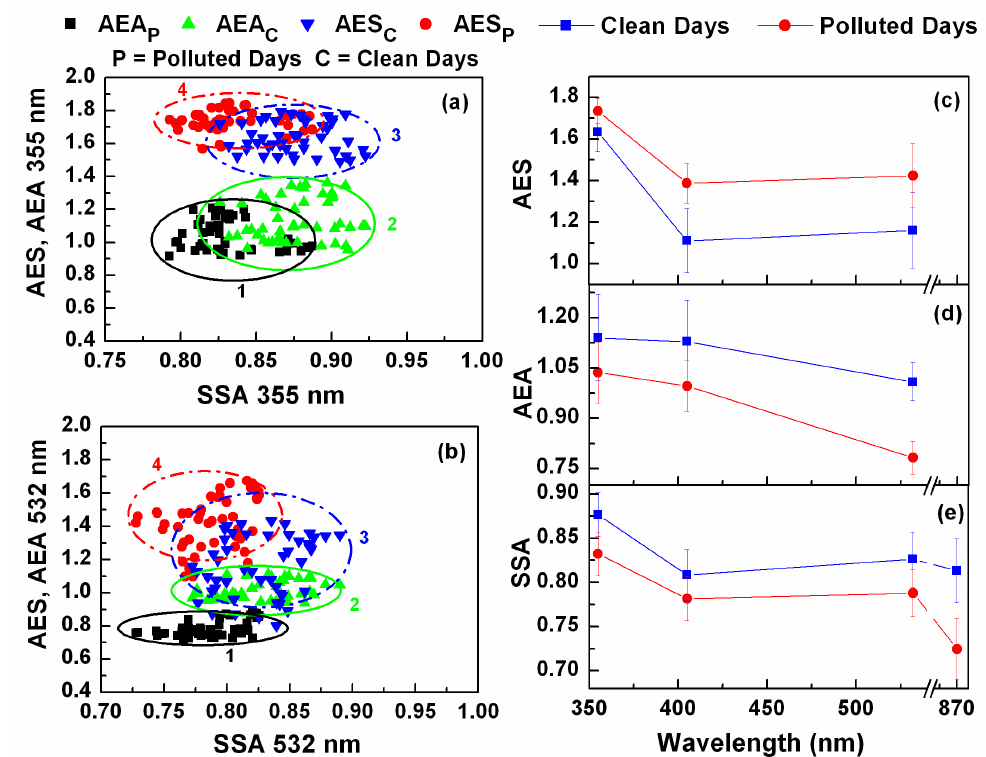
Fig. 8. Ambient intensive aerosol optical properties from 18 December 2009 to 18 January 2010. Half-hour average AES and AEA versus single scattering albedo (SSA) for (a) 355nm and (b) 532nm. Averaged (c) AES and (d) AEA for “clean days” and “polluted days” using 870nm as a reference wavelength. (e) similar plot for